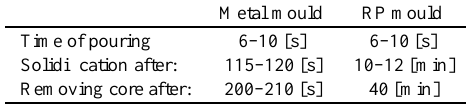
Table 1 Comparison between casting parameters used in case of